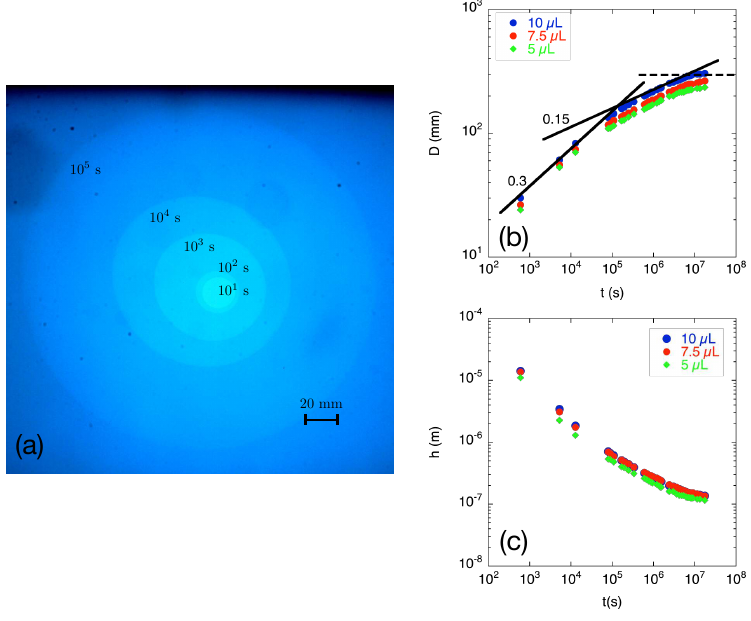
Figure 3: Silicone oil spreading – (a) Superimposition of 5 pictures taken at 10, 10 2 , 10 3 , 10 4 and 10 5 s intervals fromabove a horizontal frosted glass plate on which a droplet (10 µ L) of silicone oil was initially released. (b) Evolution of the oil stain diameter D as a function of time (log-log plot) for a droplet of 5, 7.5 and 10 µ L (green diamonds, red bullets and blue bullets, respectively). The straight lines are power laws for which the exponents are indicated in the figure. The dashed line corresponds to the saturation regime for which the stain did not expand any longer. (c) Evolution of the average thickness h of the oil stain as a function of time for three droplet volumes (the same volumes and symbols are used as in (b)). Note that the data in (b) were not obtained from the pictures